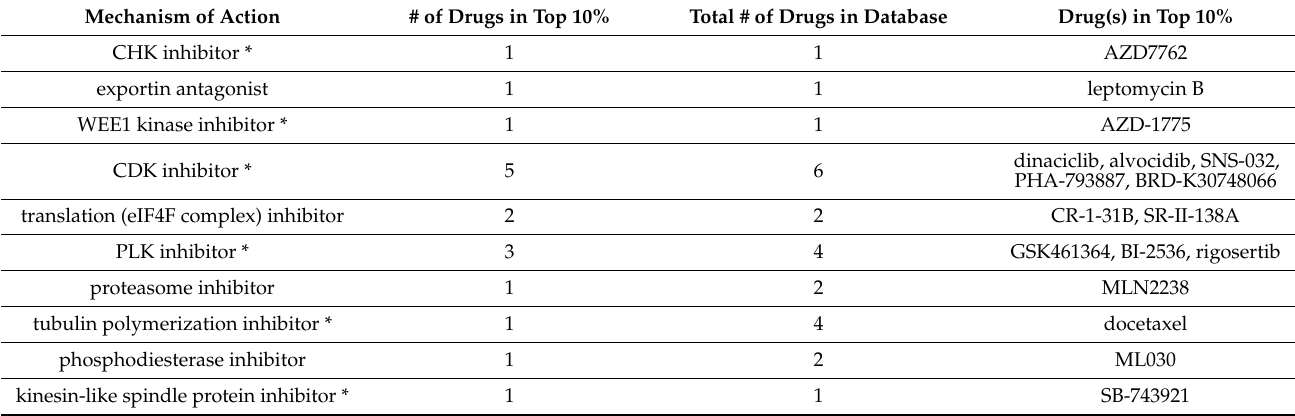
Table 1. Drug pathways predicted to be effective for TNBC based on the differential imputed response analysis. Table 1 contains the mechanisms of action (MOA) of the compounds that were in the top 10% most effective for TNBC based on both effect size and p -value from the imputed sensitivity analysis in the TCGA breast cancers. The rows are in ordered from most to least significant based on t-test p -value of the first drug listed in the drug column. A count column for the total number of drugs with the same MOA are also included. Asterisk (*) in Mechanism of Action column indicate drugs that target cell cycle/DNA repair